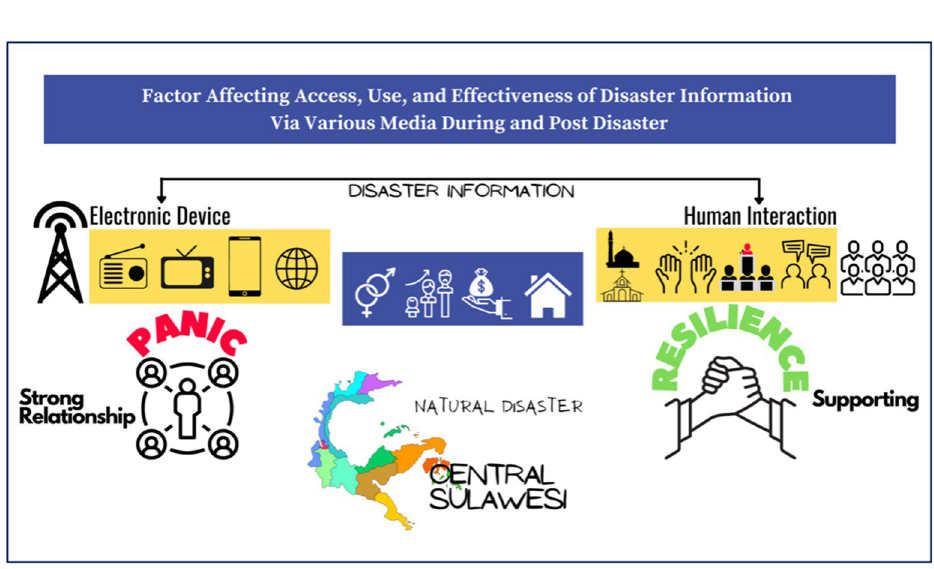
Fig 2. Illustration of relationship between disaster information from various media and the panic of affected community during the event of natural disaster.